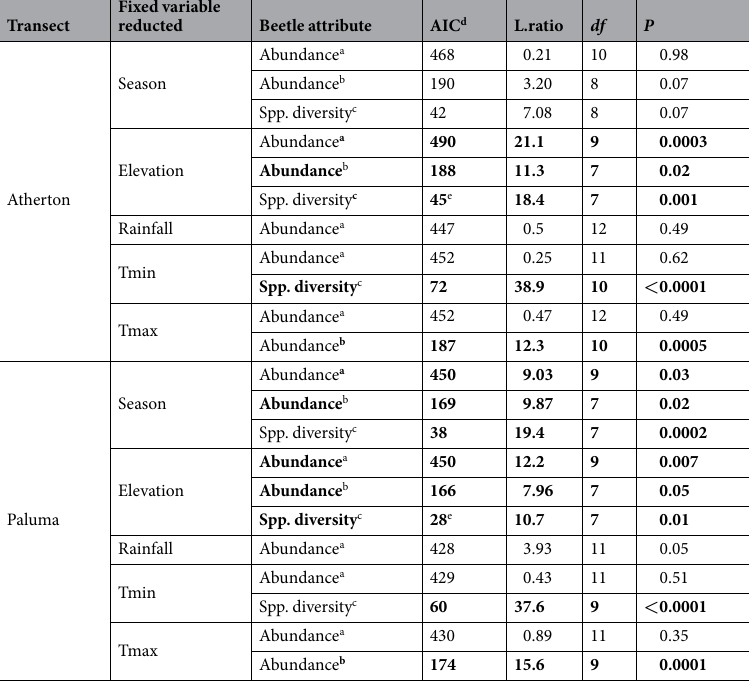
Table 1. Reduced LME models of total abundance, abundance of the seven focal families and species diversity of the seven focal families. Each fixed variable has been individually reduced from the full model (full models shown in Table S2) and results from both AIC in REML and by Maximum Likelihood are shown. Significant variables are shown in bold. a Total abundance (mean per trap day) full model: lme(TotalAbund ~ Elevation + Season + Rainfall + Tmax + Tmin,random = ~1|Site.group). b Abundance of the seven focal families (mean per day) full model: lme(FamAbund~Elevation + Season + Tmax,random = ~1|Site. group). c Species diversity of the seven focal abundant families (mean per day) full model: